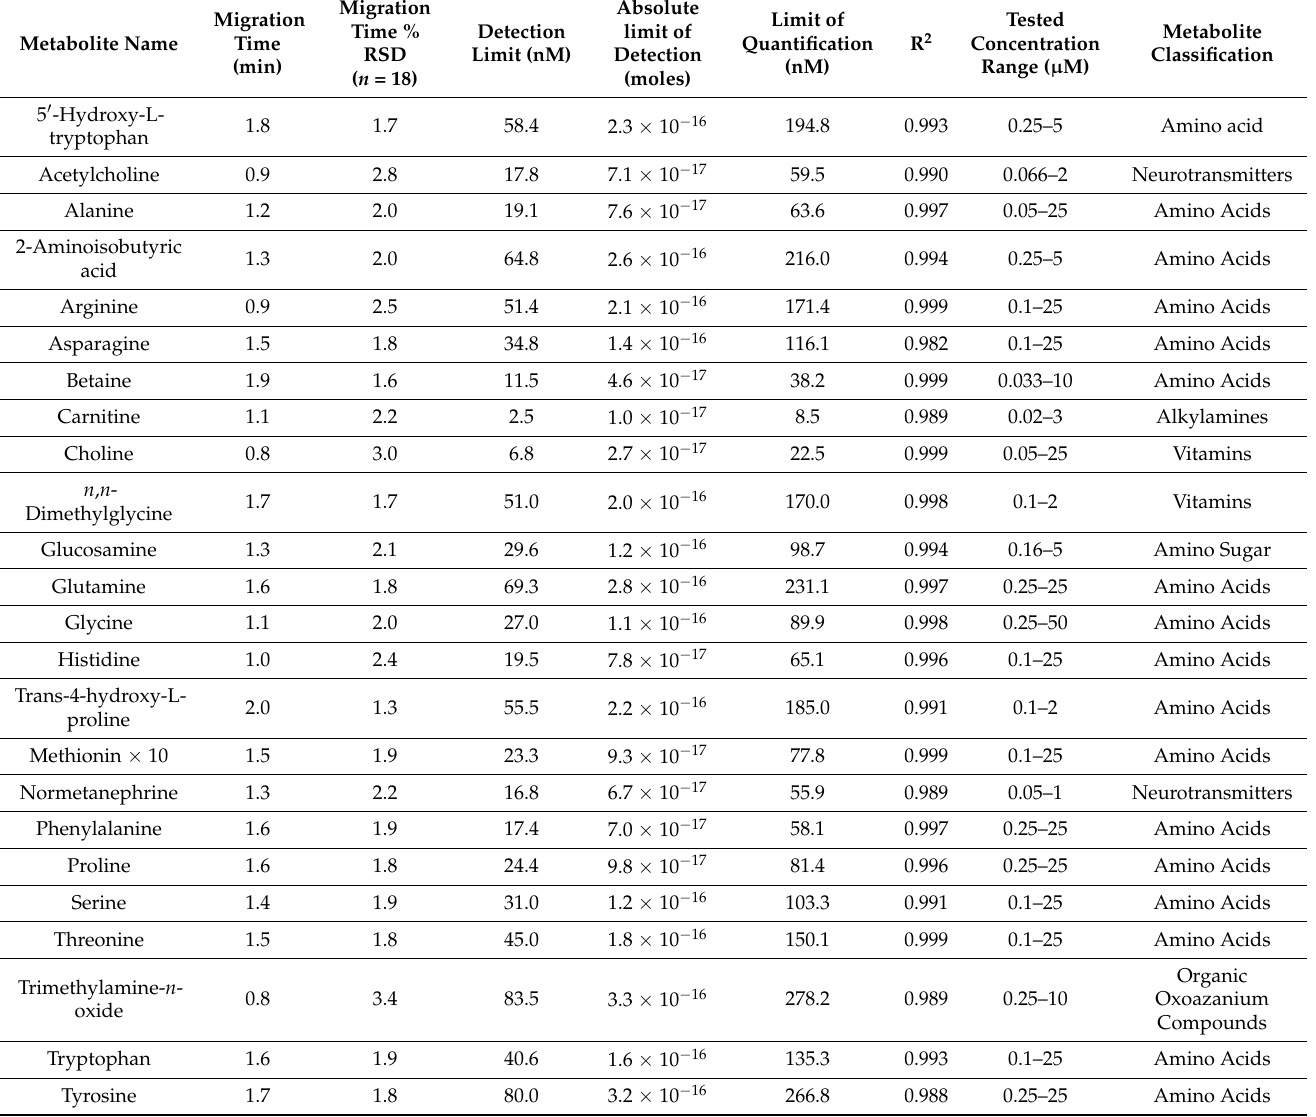
Table 1. Linearity, detection limits, limits of quantification, and migration time analysis for